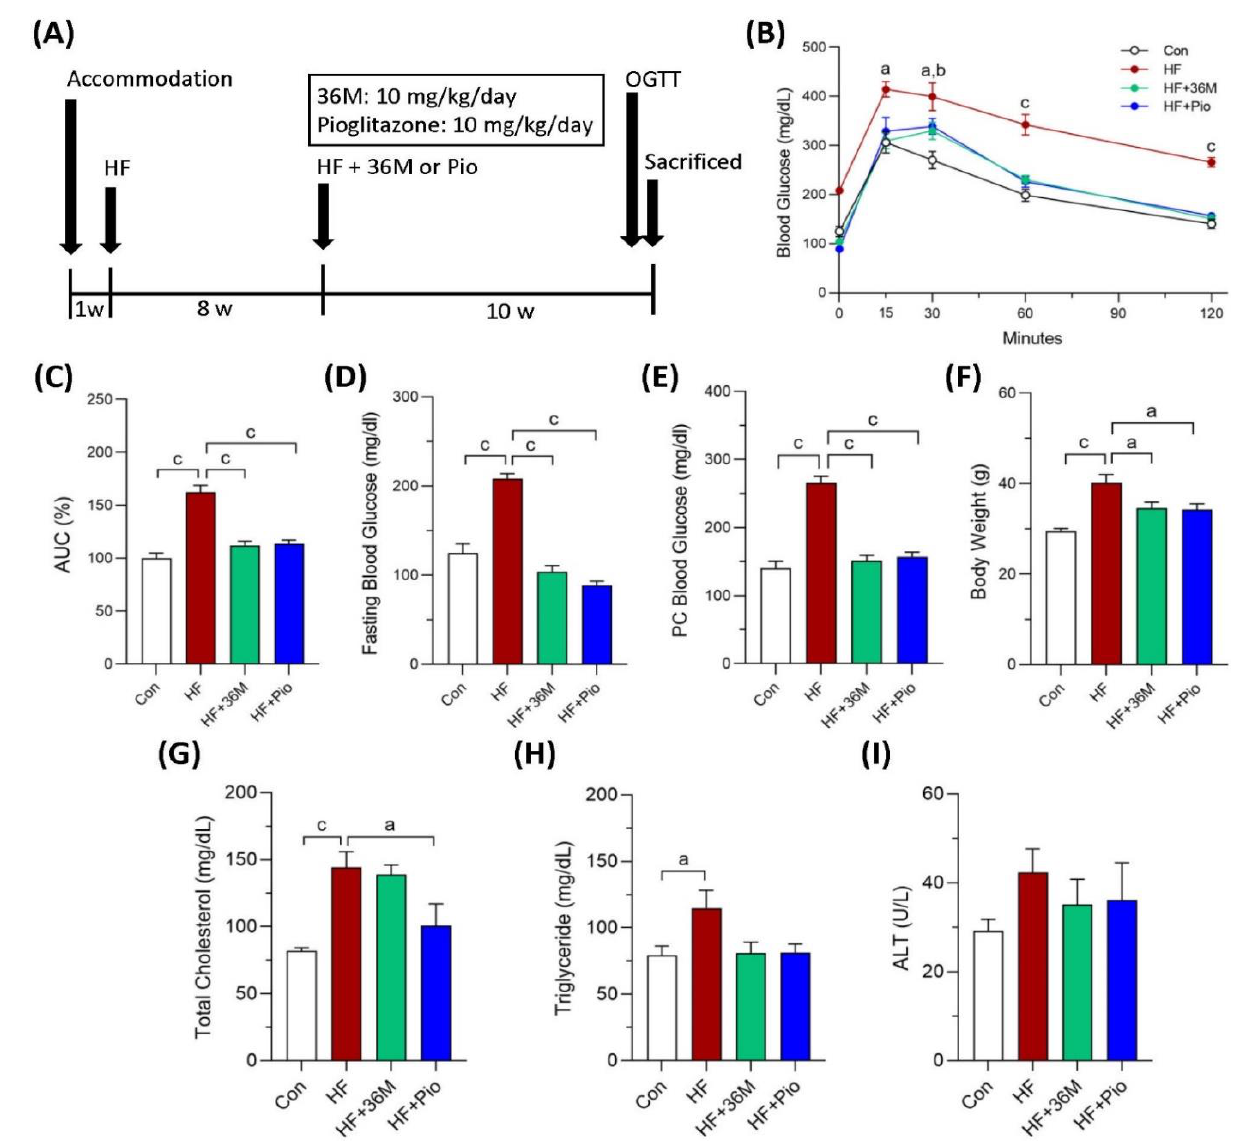
Figure 4. The biochemical results of the mice in the treatment model. ( A ) Scheme of the treatment model. ( B ) Results of the OGTT of the mice detected at the 10th week of administration of 36M or pioglitazone. ( C ) Area under curve (AUC) of the OGTT results. ( D – I ) Fasting blood glucose, postprandial (post cibum; PC) blood glucose, body weight, total cholesterol, triglyceride, and alanine aminotransferase (ALT) of the mice at the end point of the experiment. Con: control; HF: high-fat diet; Pio: pioglitazone. Data are mean ± SE (n = 8). a: p < 0.05; b: p < 0.01; c: p < 0.001.